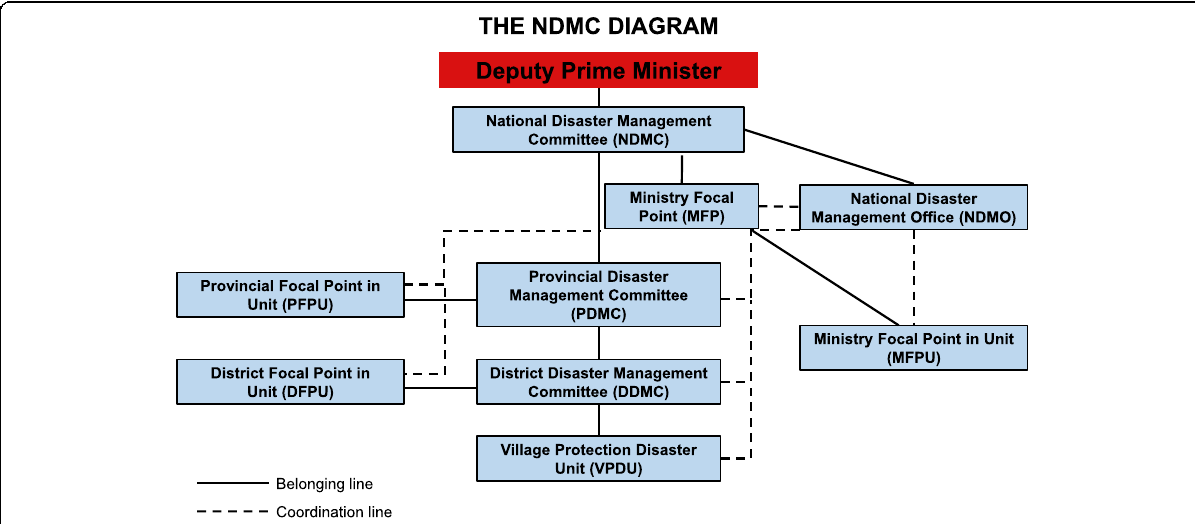
Fig. 2 National Disaster Management Committee Diagram of Lao